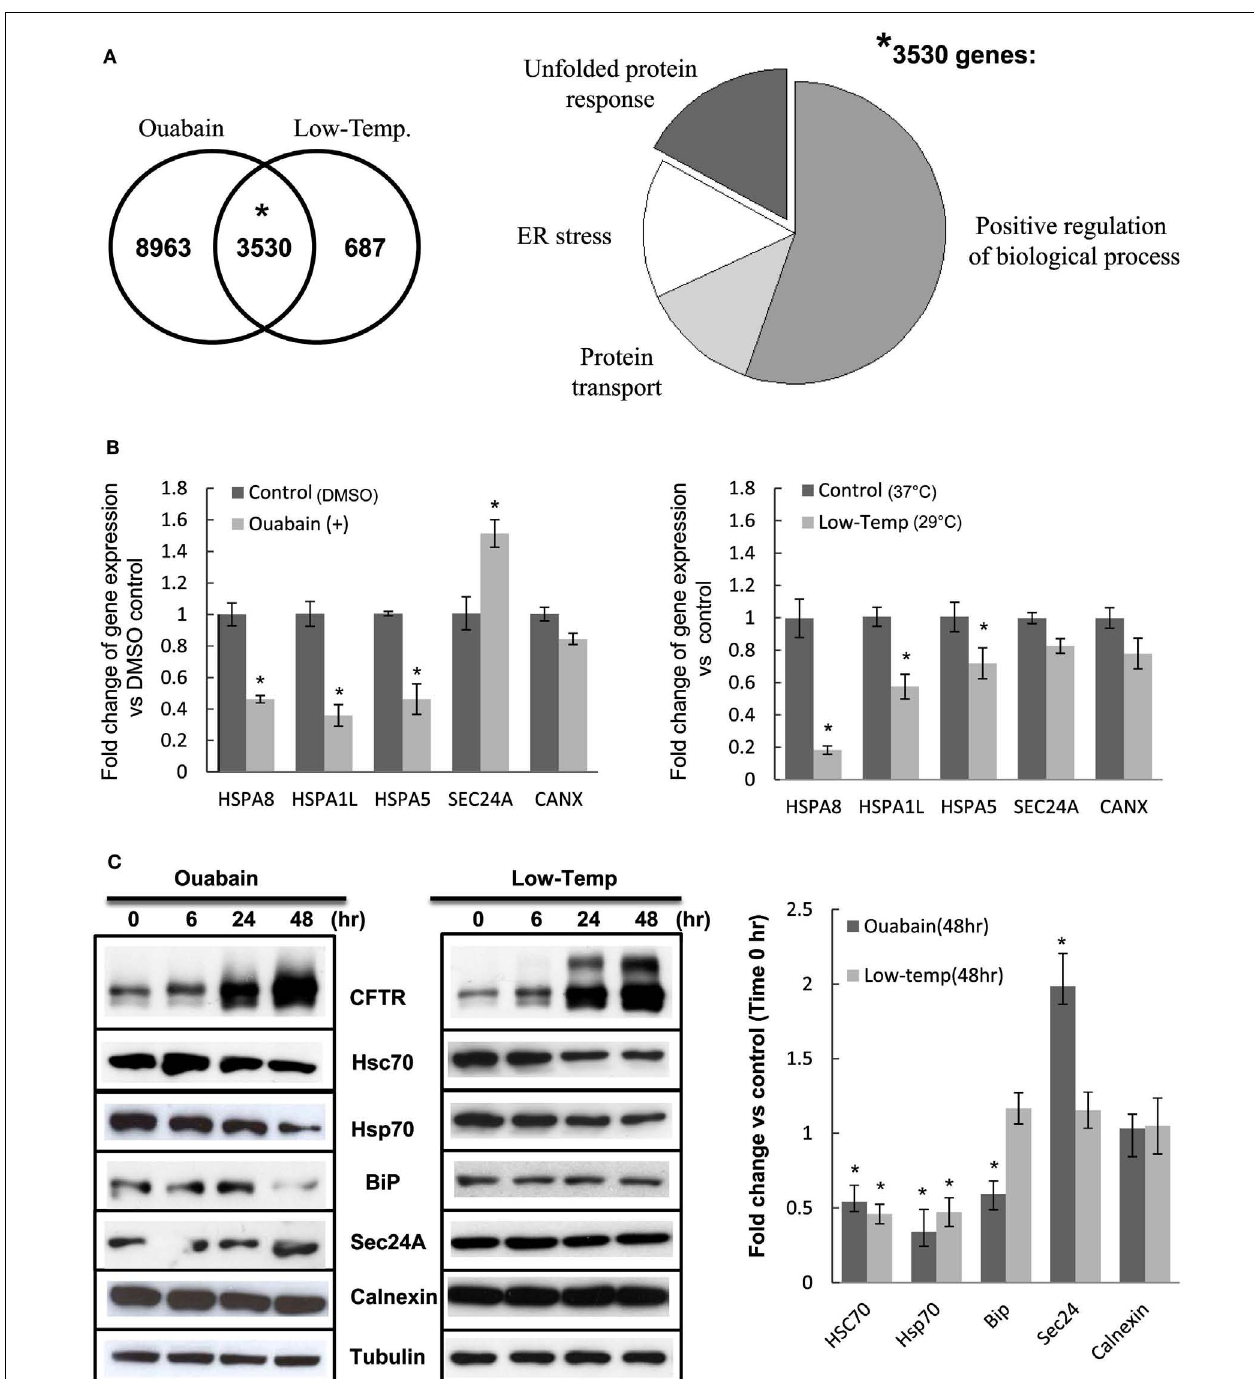
HSPA1L, HSPA5, SEC24A, and CANX. Data are presented by the fold change of gene expression vs. DMSO control with mean ± SEM of n = 3 (* P < 0.05) (C) CFBE/F508del-CFTR cells were treated with 0.1 µ M ouabain or 29˚C (Low-Temp.) for 6, 24, or 48h, then the cell lysates were analyzed by immunoblotting using the individual antibodies.The bar graph shows quantification of the band intensities for blots expressed as fold change vs.Time 0h control.Values in the experiments described are presented as means ± SD ( n = 3). Means were tested for statistical significance using a Student’s t -test (* P <